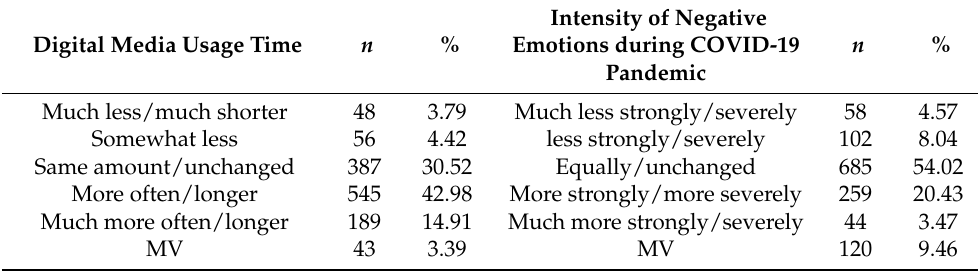
Table 3. Frequency data for the items digital media usage time and intensity of negative emotions during the COVID-19 pandemic.